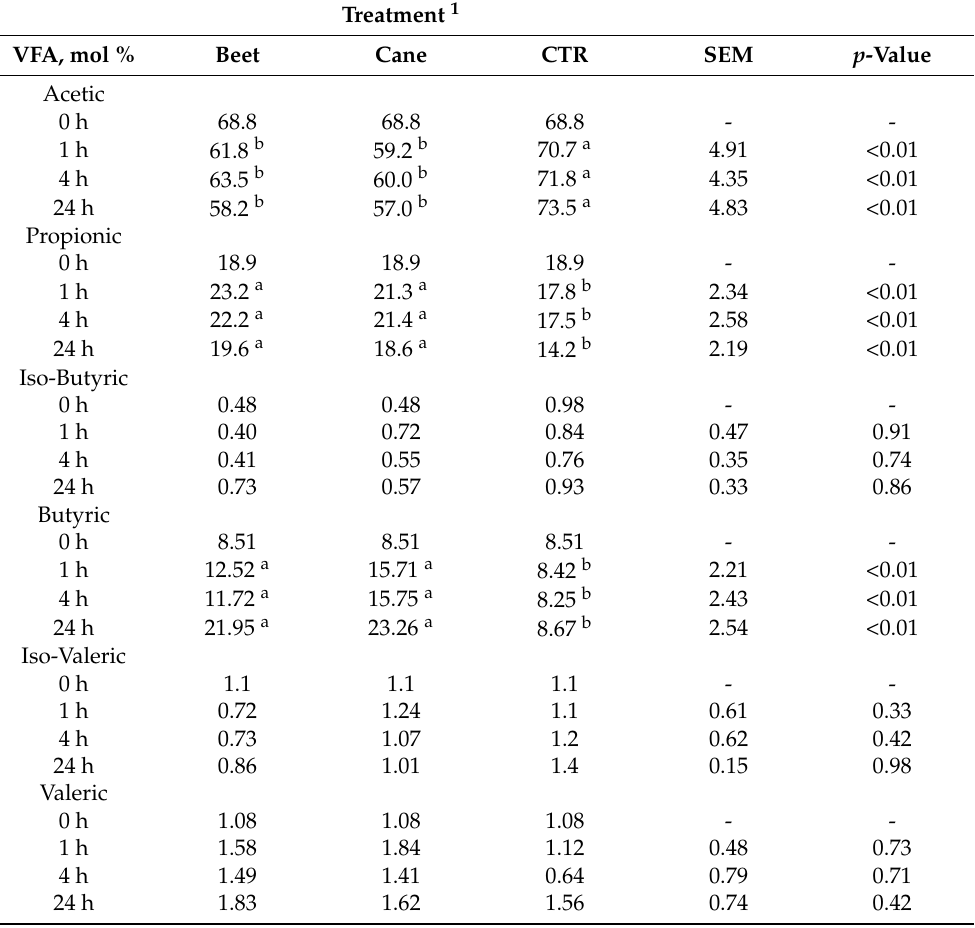
Table 3. Averaged molar percentage of single VFAs produced by treatments during in vitro